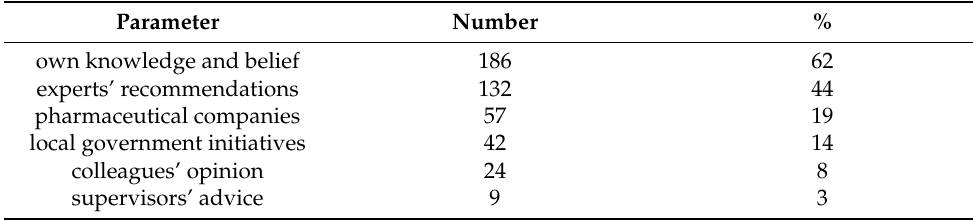
Table 6. Reasons for HPV vaccine recommendations by